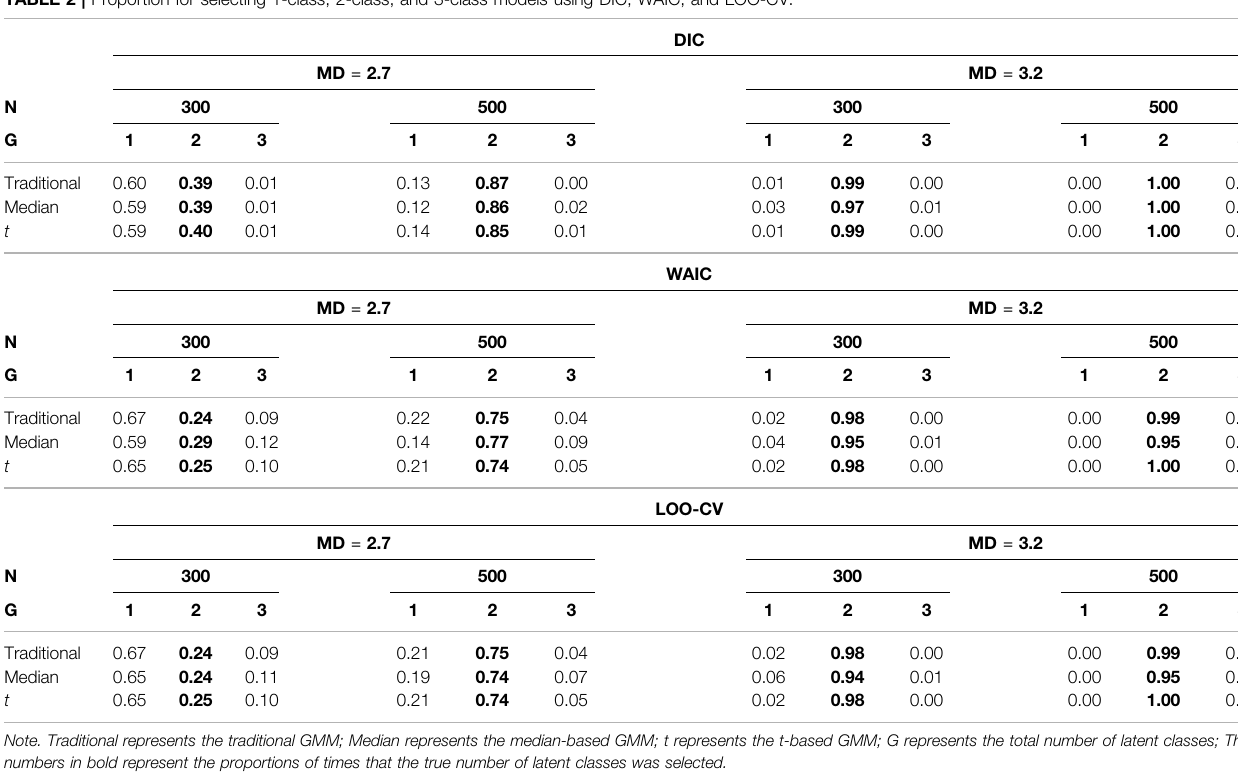
TABLE 2 | Proportion for selecting 1-class, 2-class, and 3-class models using DIC, WAIC, and LOO-CV.